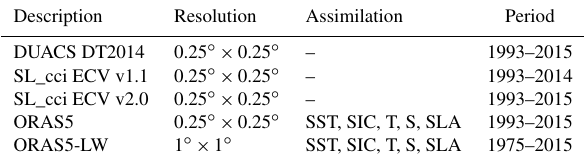
Table 2. Summary of the ORAs used for the SL_cci v2.0 ECV evaluation. DUACS DT2014 MSLA (Pujol et al., 2016) is now dis- tributed by CMEMS (previously AVISO). ORAS5 is the ECMWF 0.25 ◦ resolution ocean–sea ice reanalysis; ORAS5-LW is the ORAS5-equivalent low-resolution (ORCA1 grid, with approxi- mately 1 ◦ resolution, with meridional refinement at the Equator) reanalysis. Both ORAS5 and ORAS5-LW have five ensemble mem- bers, generated by a generic perturbation scheme (Zuo et al., 2017). SST stands for sea surface temperature, SIC for sea ice concentra- tion and SLA for sea level